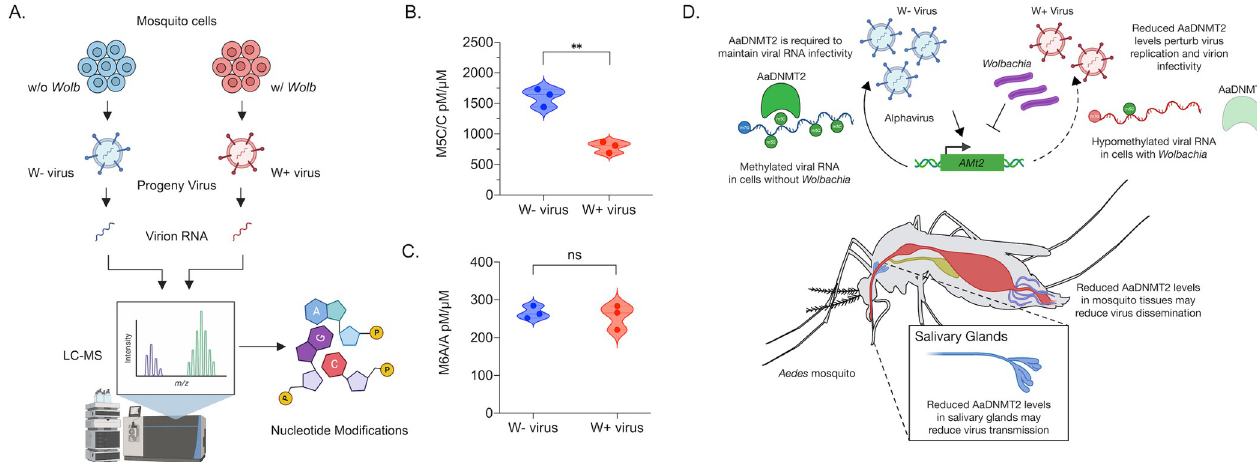
Fig 6. Presence of Wolbachia is associated with altered virion RNA methylation. (A) RNA isolated from progeny viruses derived from mosquito cells colonized with (W+ virus) or without (W- virus) Wolbachia were subjected to LC-MS/MS analyses to determine their nucleotide content. (B) Normalized 5-methyl cytosine (M5C) content of RNA isolated from W- and W+ viruses represented as a ratio of total unmodified cytosine content. Unpaired two-tailed t- test, p = 0.0013, t = 8.080, df = 4 (C) Normalized 6-methyl adenosine (M6A) content of RNA isolated from W- and W+ viruses represented as a ratio of total unmodified adenosine content. Unpaired two-tailed t-test, p = 0.666, t = 0.4643, df = 4. Error bars represent standard error of mean (SEM) of three independent virus preps from each cell type. �� P < 0.01; ns = non-significant. (D) Model delineating the role of Aedes cytosine MTase AaDNMT2 in pathogen blocking. MTase (AMt2) expression is induced following alphavirus infection in mosquitoes constituting a proviral environment. Virion RNA produced under these conditions are m5C-methylated and efficiently disseminate across mosquito cells. Elevated MTase expression in salivary gland tissues result in the production of virions (W- virus) containing methylated viral RNA that are infectious in mammalian cells, which promotes efficient transmission. In contrast, MTase expression is reduced in mosquitoes colonized with Wolbachia and inhibition occurring at early stages of virus infection prevent virus-induced MTase upregulation. Consequently, virion RNA (W+ virus) is hypomethylated at cytosine residues, which compromise viral dissemination and transmission events. Graphical assets were made in BioRender (https://biorender.com).